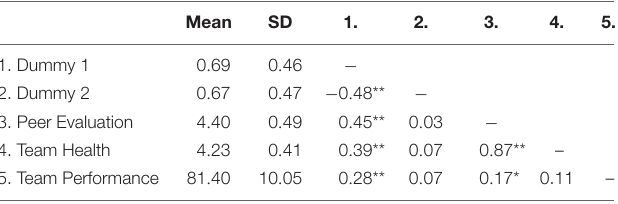
TABLE 1 | Correlations and descriptive statistics (team level of analysis).